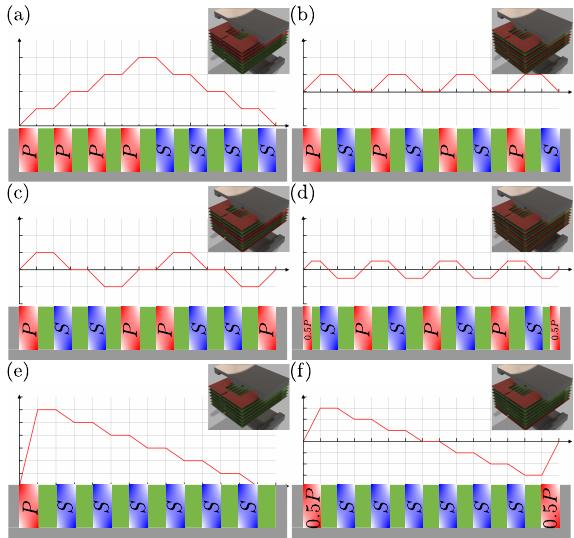
Figure 7. MMF distributions; ( a ) non-interleaved arrangement (P-P-P-P-S-S-S-S), ( b ) fully inter- leaved arrangement (P-S-P-S-P-S-P-S), ( c ) alternative interleaved arrangement (P-S-S-P-P-S-S-P), and ( d ) improved interleaved arrangement (0.5P-S-P-S-P-S-P-S-0.5P), ( e ) non-interleaved arrangement for insulation requirements while having higher voltages (P-S-S-S-S-S-S), ( f ) partially interleaved arrangement for insulation requirements while having higher voltages (0.5P-S-S-S-S-S-S-0.5P).